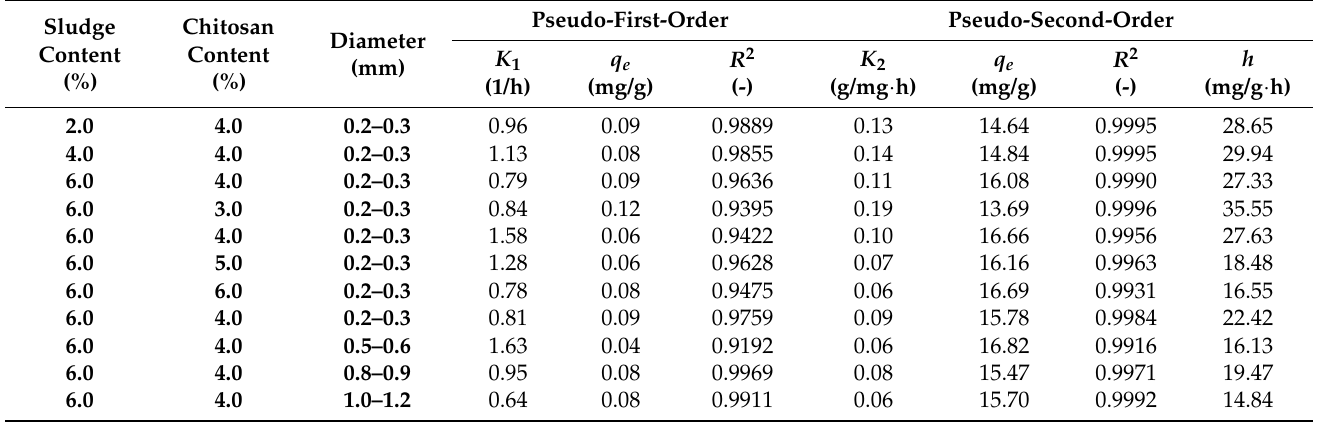
Table 2. Comparison of pseudo-first-order model and pseudo-second-order model parameter values for different sludge contents, chitosan contents, and diameters of the